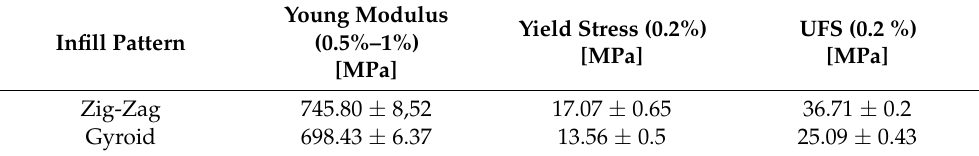
Figure 12. Stress–strain curves from three-point bending tests ( a ); failed flexural specimens: gyroid ( top ) and zig-zag ( bottom ) ( b ). Table 5. Three-dimensional-printed PCL specimens’ flexural